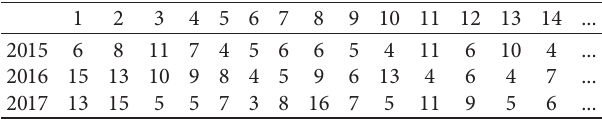
Table 1: Daily sales volume statistics of calligraphy practice products of a company from 2015 to